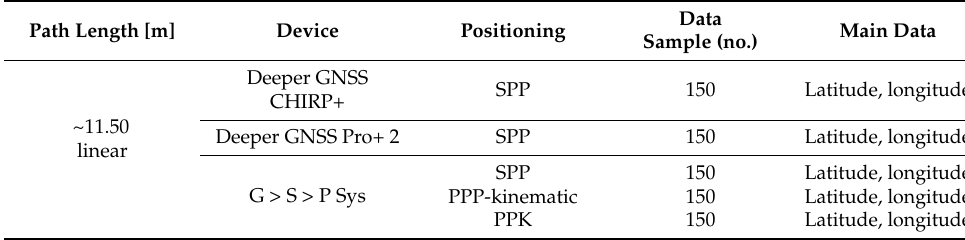
Table 4. Dynamic datasets composition of the sea test.